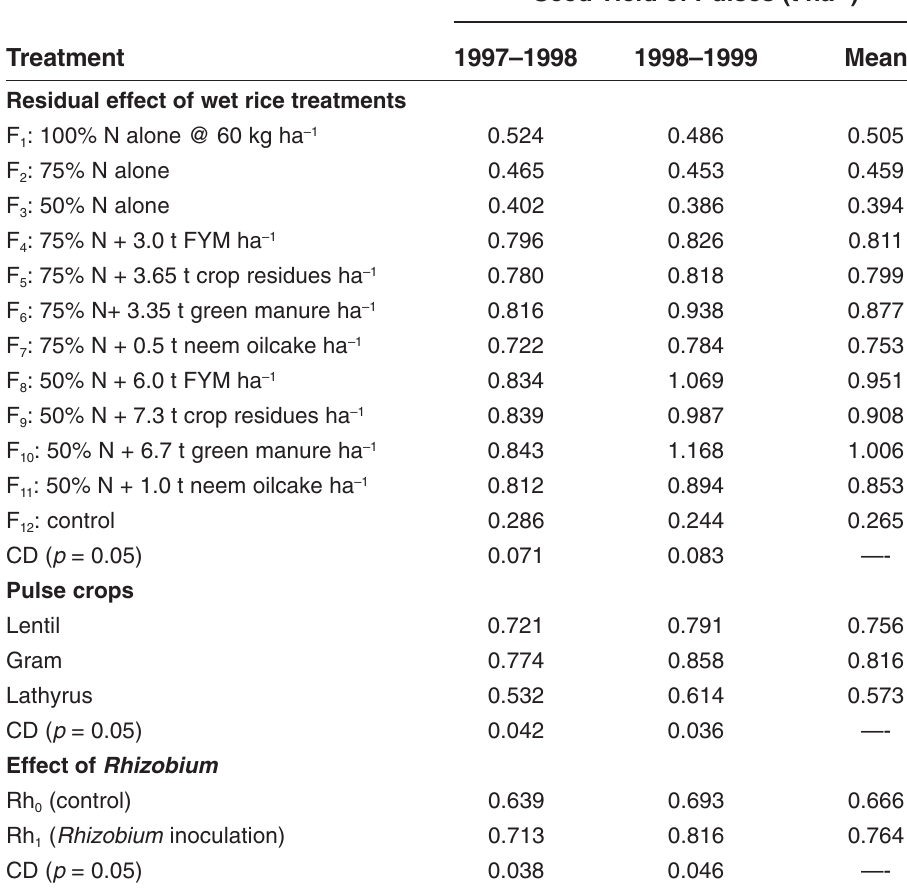
Seed Yield of Winter Pulse Crops in Terms of Lentil Grain Equivalent